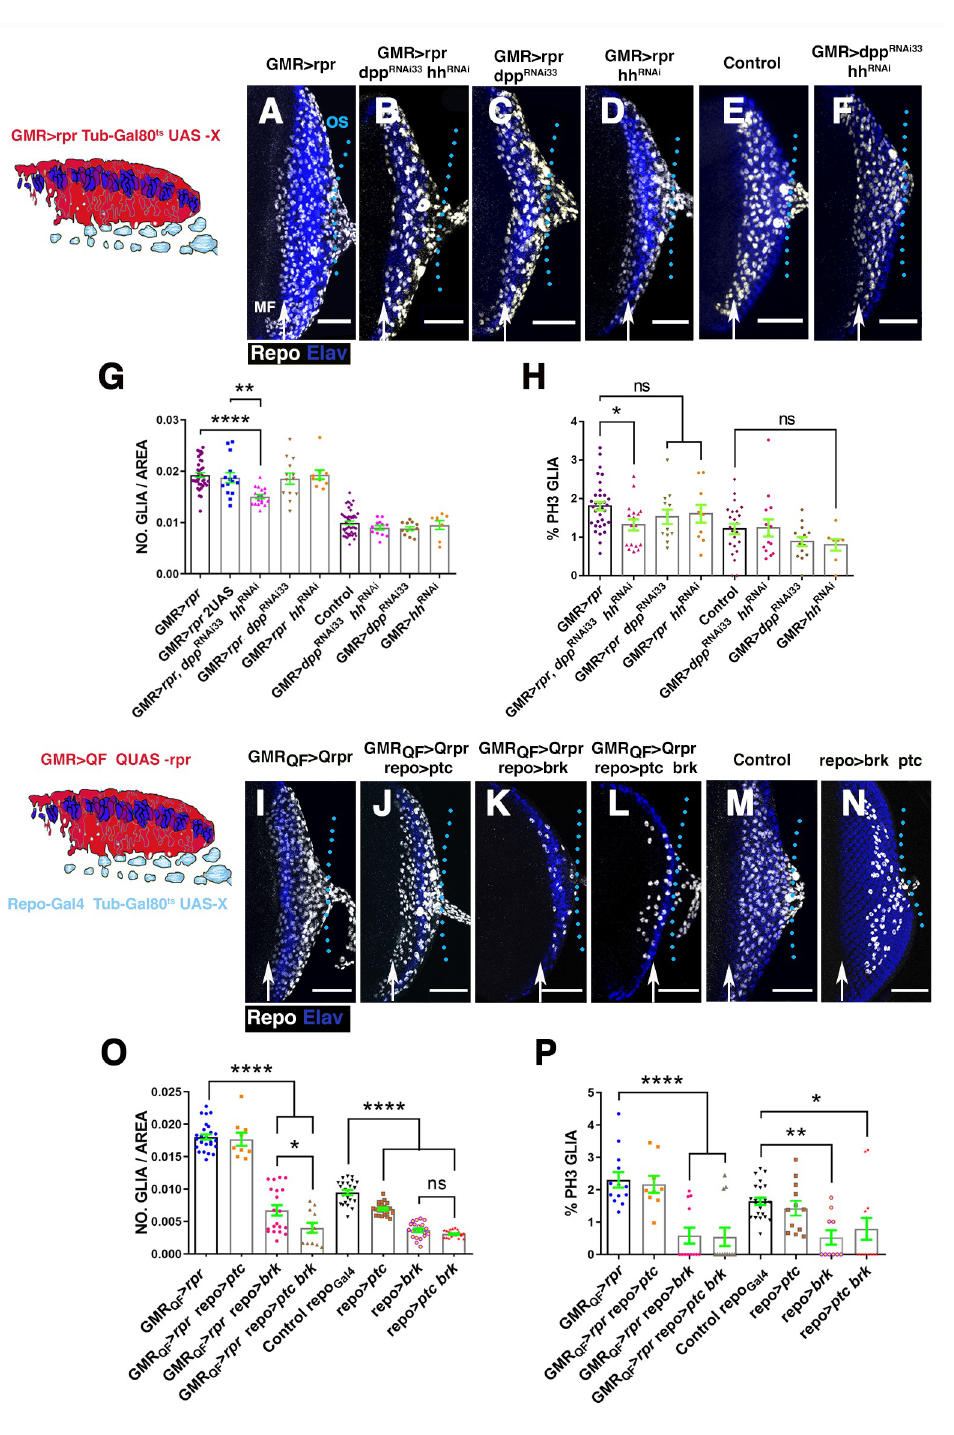
Fig 8. The down-regulation of Dpp and Hh signalling reduce glial response. (A–F and I–N) Projections of confocal images of third instar eye discs stained with anti-Elav (blue) and anti-Repo (white). (A–F) Effects caused by the down- regulation of Dpp and Hh signalling in the damaged region. The schematic illustration on the left represents a transverse section of an eye disc where the region marked in red (expression domain of GMR-Gal4) corresponds to the area of the discs that has been damaged at the same time that Dpp and/or Hh signalling were depleted. (A) UAS-rpr/+; GMR-Gal4 tub-Gal80 ts /+ damaged eye disc. (B) Damaged UAS-rpr/+; GMR-Gal4 tub-Gal80 ts / UAS-hh RNAi ;